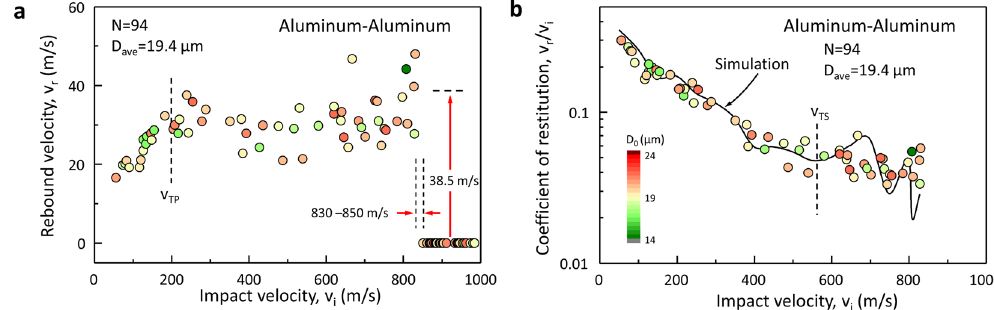
Figure 5. The real-time dynamic characteristics of Al-particles impacting Al-surface. ( a ) Rebound velocity of aluminum particles in Al-Al collision. ( b ) Coefficient of restitution of aluminum particles in Al-Al collision with FE simulation results for 19 µ m diameter